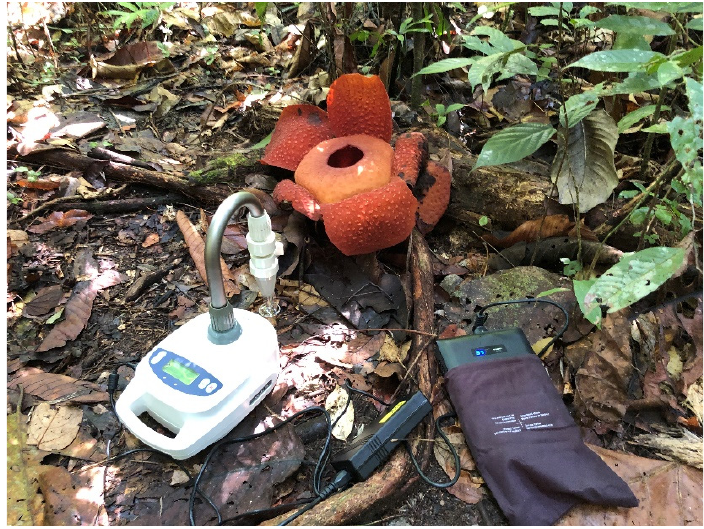
Figure 1. Air sampling device used in rainforest of Sarawak, Malaysia.